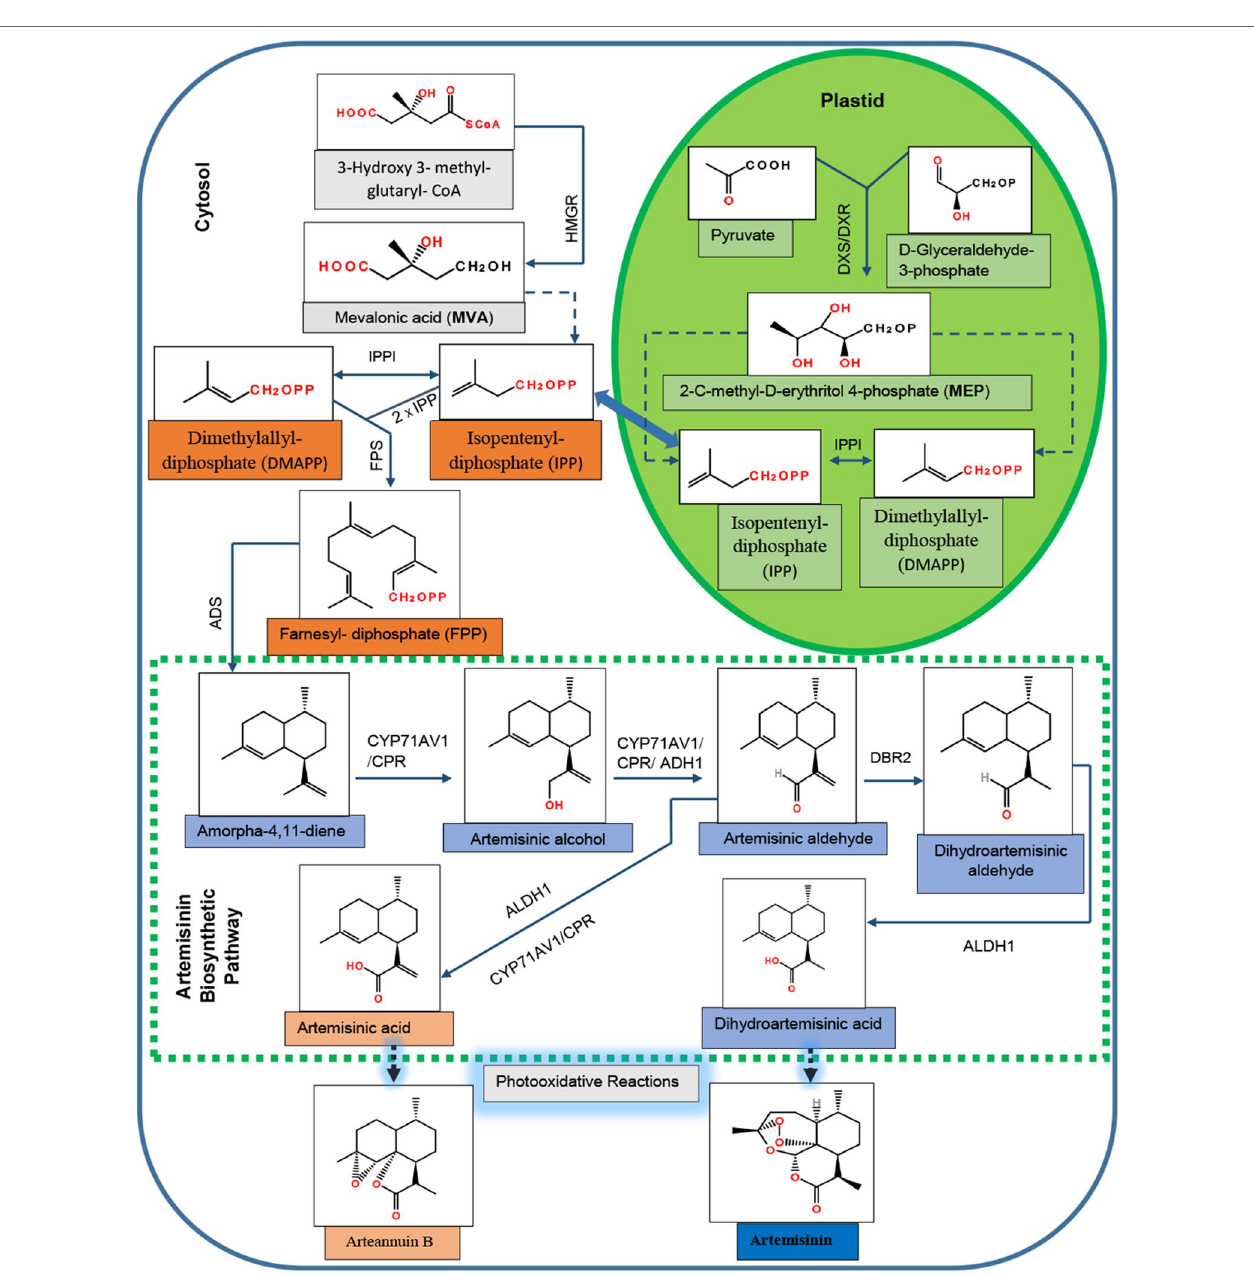
FIGURE 1 | Biosynthetic pathway for artemisinin in Artemisia annua. HMGR, 3-hydroxy-3-methylglutaryl-CoA reductase; DXS, 1-deoxyxylulose 5-phosphate synthase; DXR, 1-deoxyxylulose 5-phosphate reductoisomerase; DMAPP, dimethylallyl diphosphate; IPP, isopentenyl diphosphate; IPPI, isopentenyl diphosphate isomerase; FPS, farnesyl diphosphate synthase; ADS , amorpha-4,11-diene synthase; CYP71AV1 , cytochrome P450 monooxygenase; CPR, cytochrome P450 reductase; ADH1, alcohol dehydrogenase I; DBR2 , double-bond reductase 2; ALDH1 , aldehyde dehydrogenase